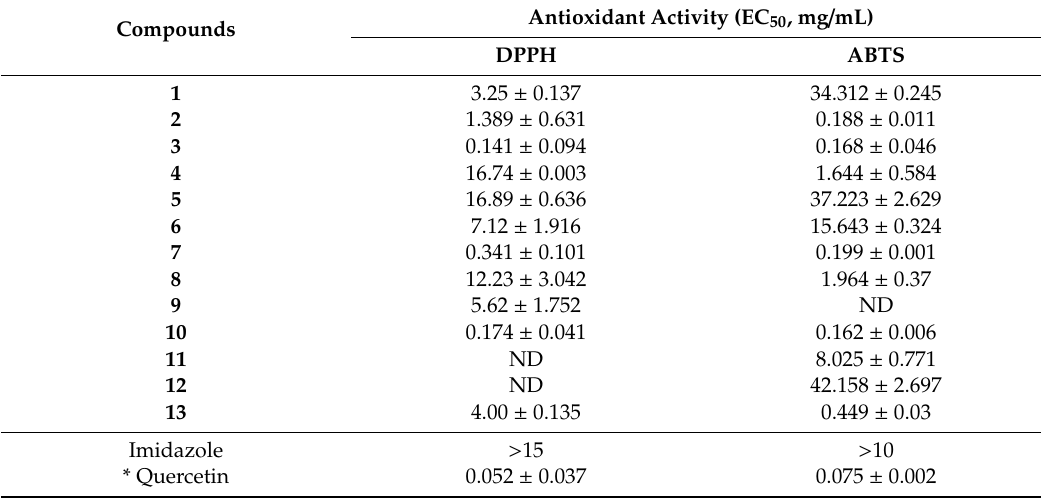
Table 1. Antioxidant activity (EC 50 ) of synthesized compounds 1 –